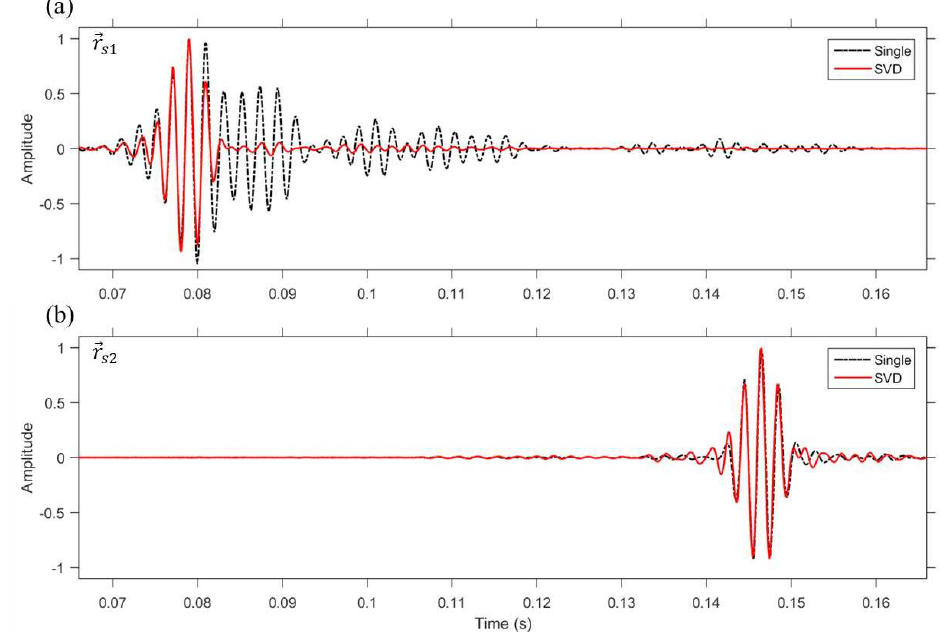
Figure 8. (Color online) Comparison of the simulated time series for the weight vector, w , with VSA-based single TR focusing (dot-dashed) and VSA-based multiple TR focusing using singular value decomposition (SVD) (solid) in sound speed mismatch environment. ( a ) Time series at (cid:126) r s 1 = (2.2 km,